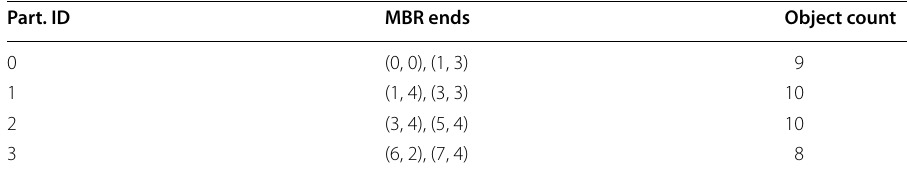
Table 3 Partition MBR to ID mapping